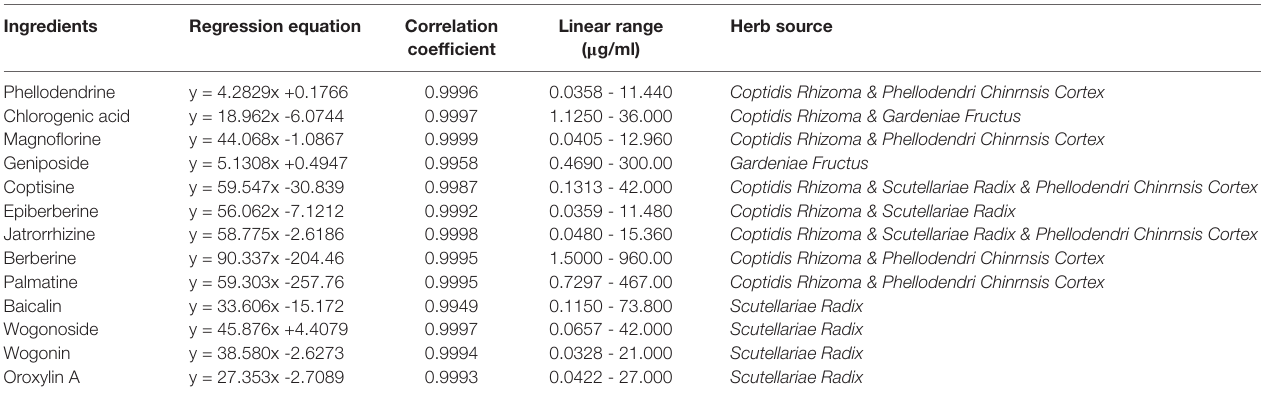
TABLE 1 | Linear regression equations of 13 active ingredients in HLJDD Ingredients Regression